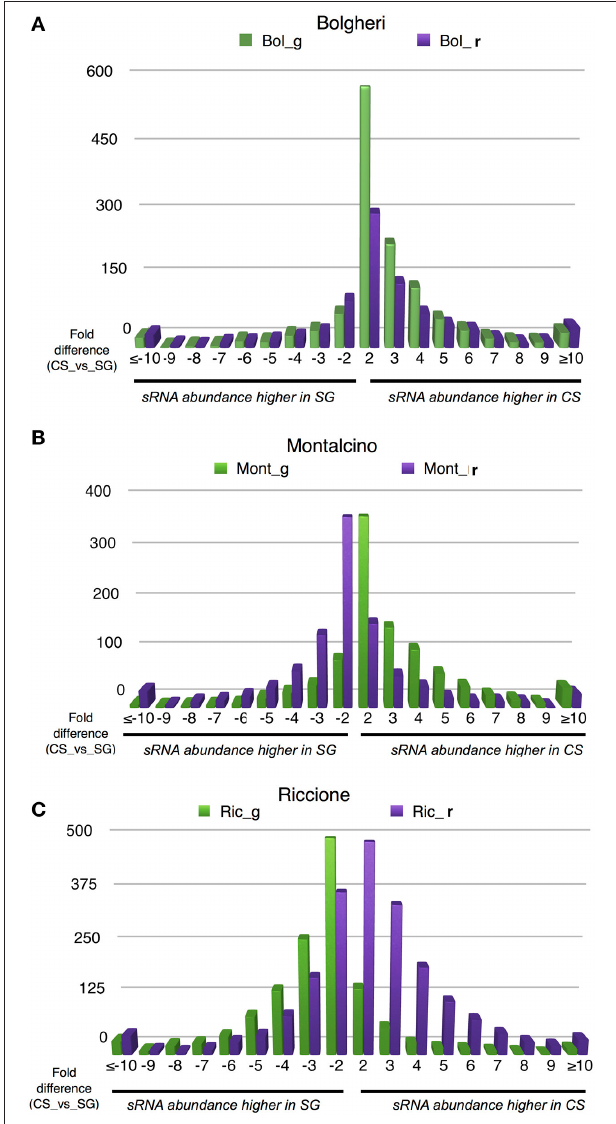
FIGURE 5 | Number of differentially regulated small RNA-generating clusters of ripened and green grape berries, collected from 2 varieties in 3 different vineyards. The CS/SG ratios were calculated based on summed cluster abundances. (A) Data relative to berries collected in Bolgheri, (B) data relative to berries collected in Montalcino, (C) data relative to berries collected in Riccione. Bol, Bolgheri; Mont, Montalcino; Ric, Riccione; CS, Cabernet Sauvignon; SG,